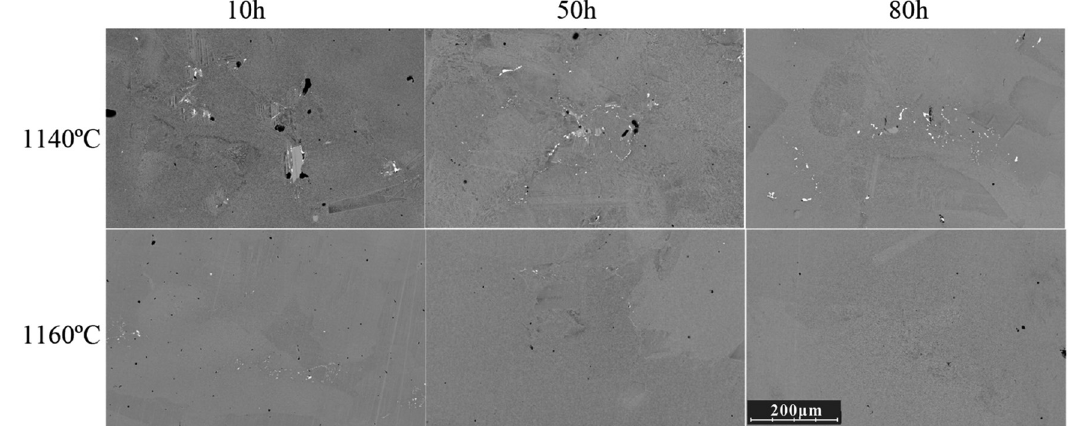
Figure 8: SEM morphology of samples from Disk II treated by a variety of homogenization